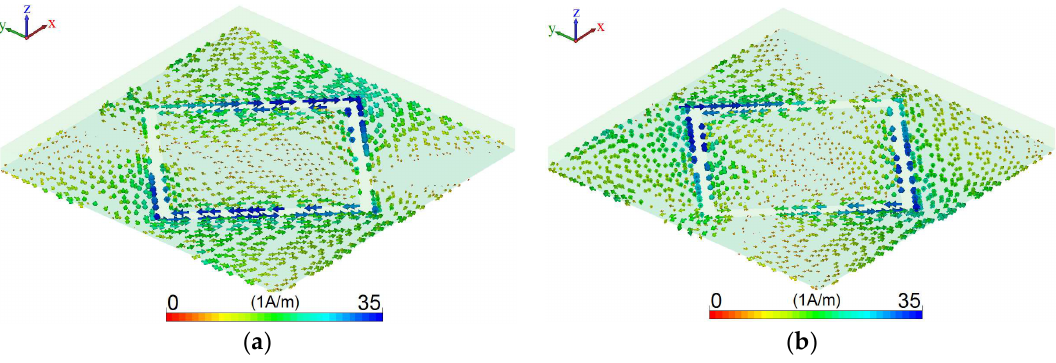
Figure 4. Simulated current densities at 3.6 GHz for ( a ) 1st feeding port and ( b ) 2nd feeding port.